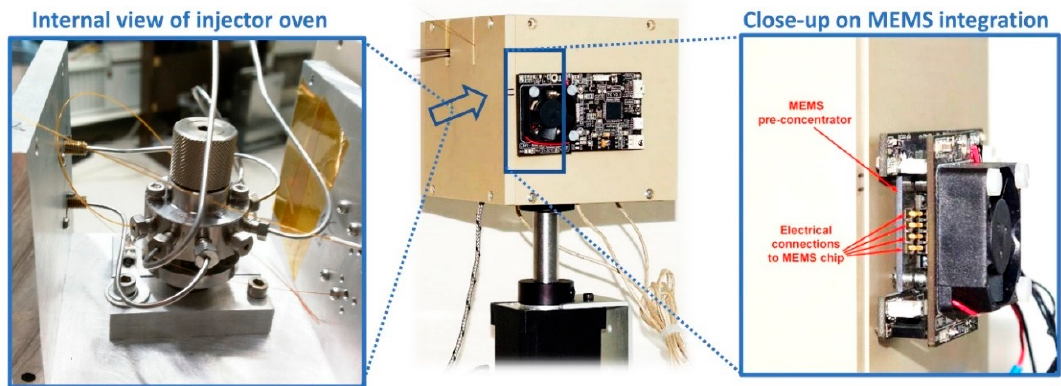
Figure 4. GC module integrating a 6-port valve inside an Aluminum oven with PEEK thermal insulation, with an internal view of the injector oven ( left ) and a close-up on the MEMS pre-concentrator and its temperature control electronics ( right ). The MEMS FAST-GC column is mounted on the other side of the oven (not visible).